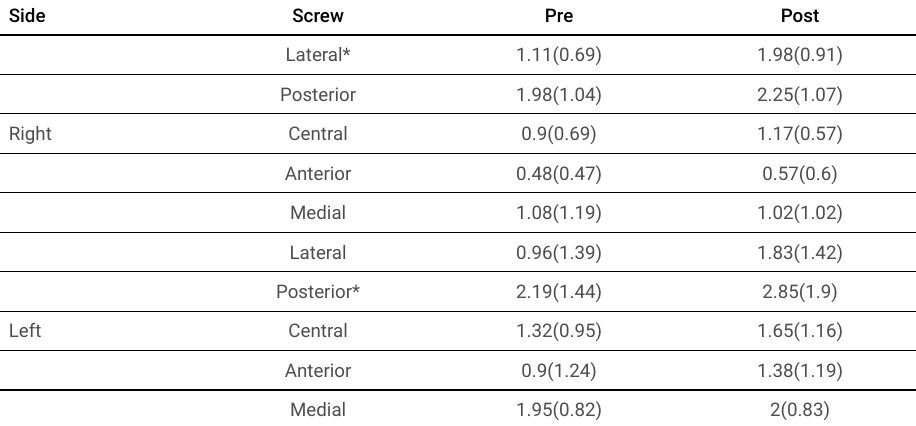
Table 2. Averages, standard deviation (SD) and statistical test result of the anterio-posterior distance (sagittal reformatting) between the screws of the glenoid fossa and mandibular condyle in the preoperative and postoperative periods of both sides. *Significant